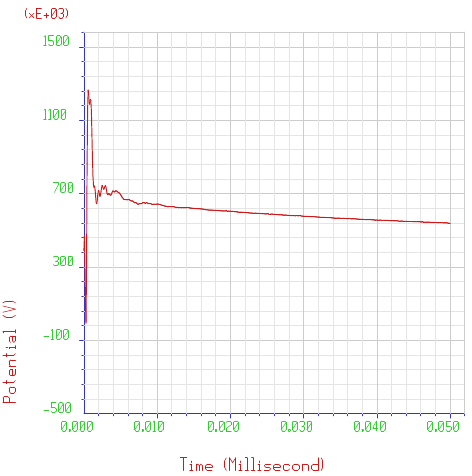
Figure 3. Example of the results obtained for one observation point from IFFT.